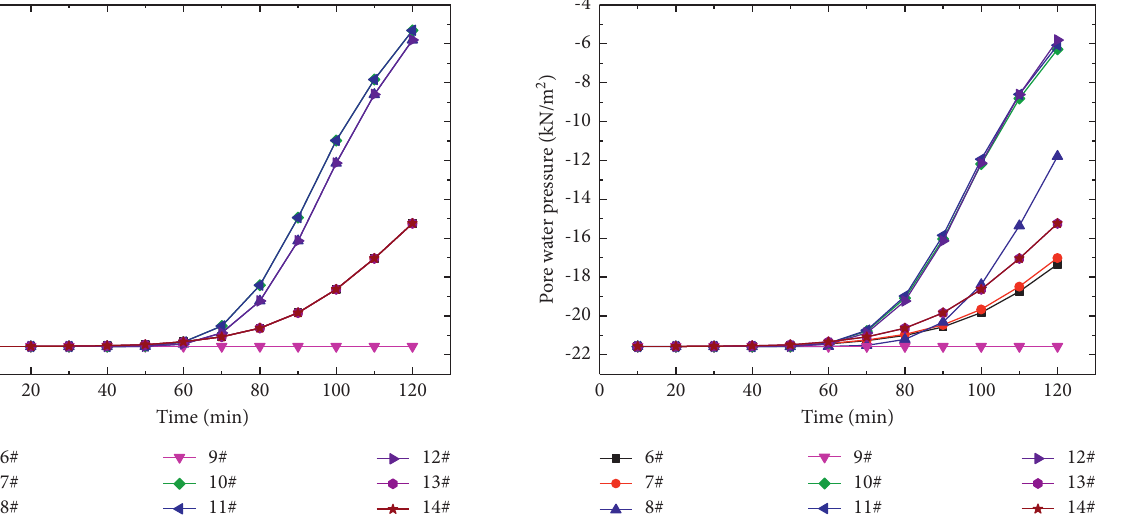
Figure 34: Pore water pressure of observation points 6–14 without any seepage wells in the numerical model.